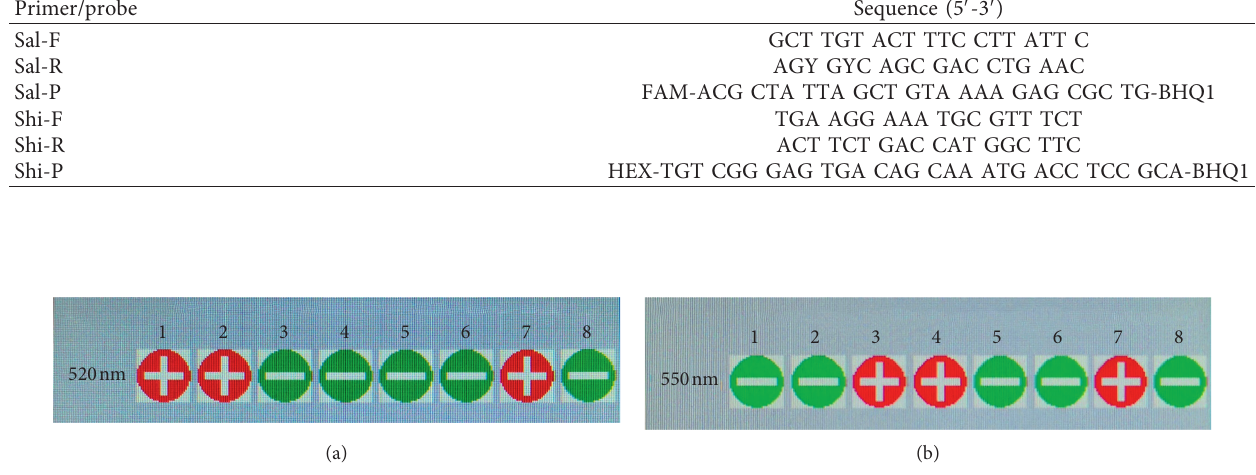
Figure 1: Representative results displayed during specificity evaluation. (a) and (b) Specificity analysis for Salmonella and Shigella, re- spectively. Samples 1 to 8 were Salmonella (AB91111, AB91018), Shigella (AB200061, AB200060), Vibrio parahaemolyticus (ATCC17802), Staphylococcus aureus (ATCC25923), positive control, and negative